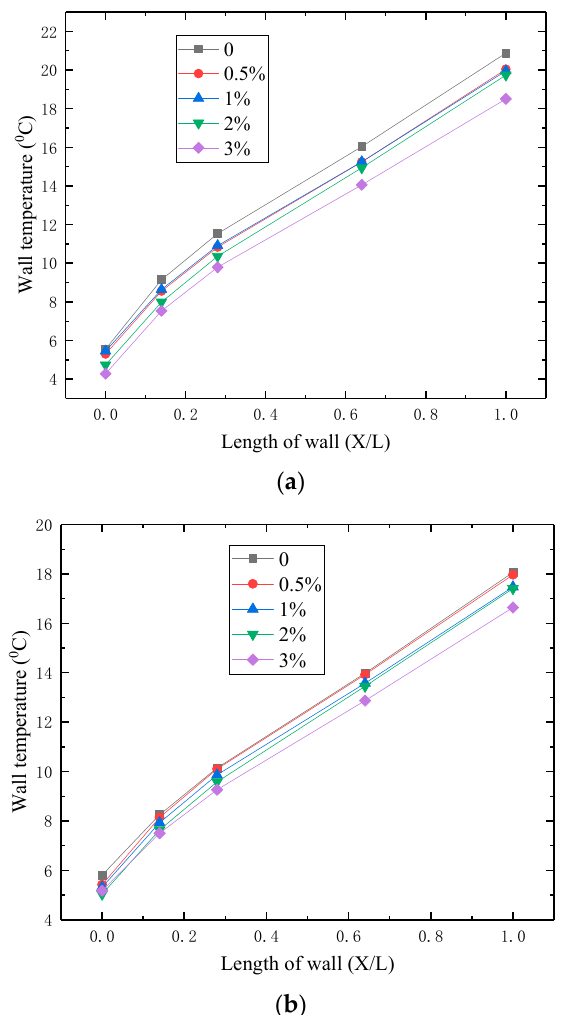
Figure 10. Wall temperature for different samples along the tube length at different flow rates: ( a ) flow rate u = 0.35 m/s; ( b ) flow rate u = 0.50 m/s.